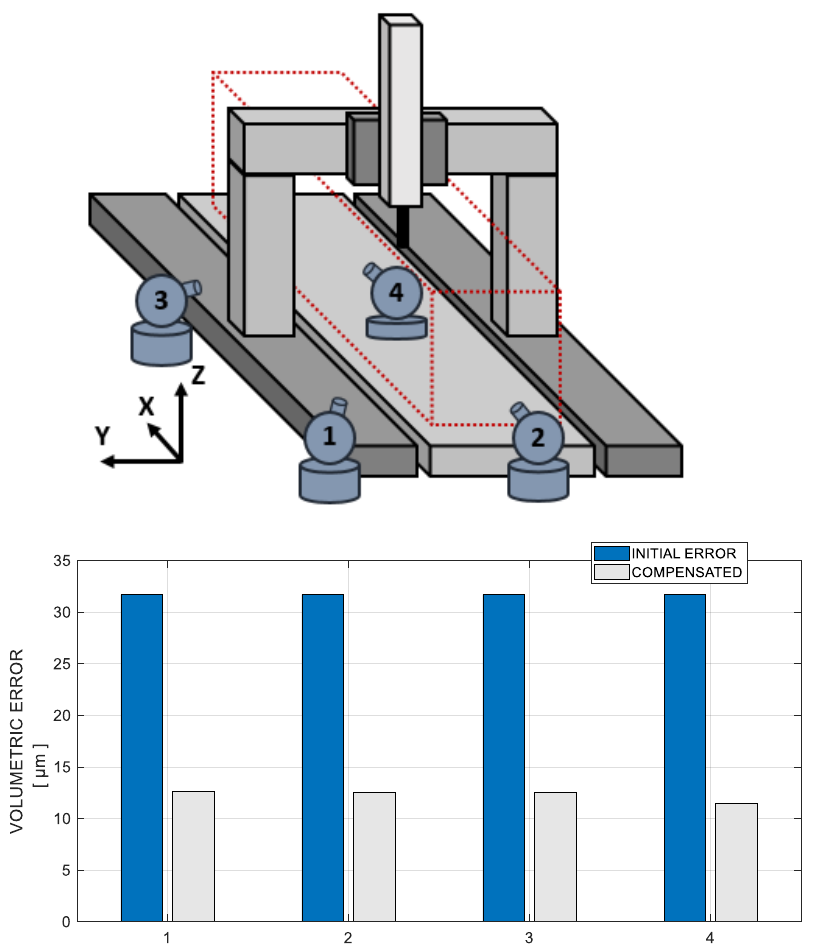
Figure 7. Measurement process schematic view and compensation results for single position and two position